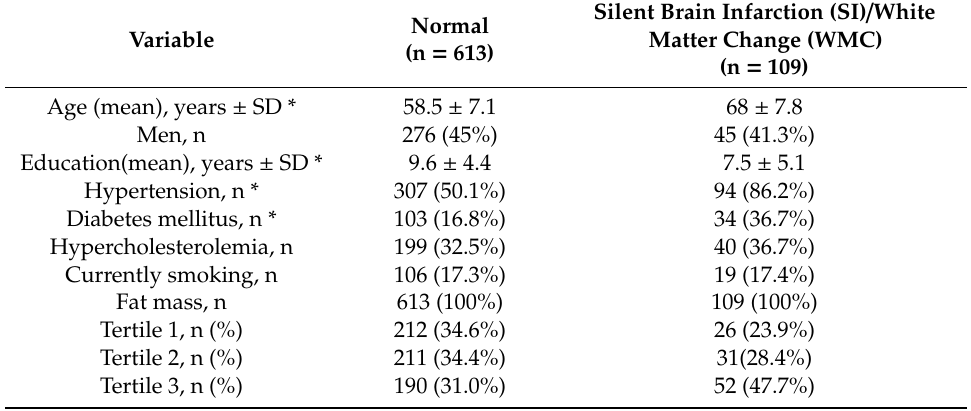
Table 1. Basic demographic data of the Prevention of Stroke and Dementia (PRESENT) study.